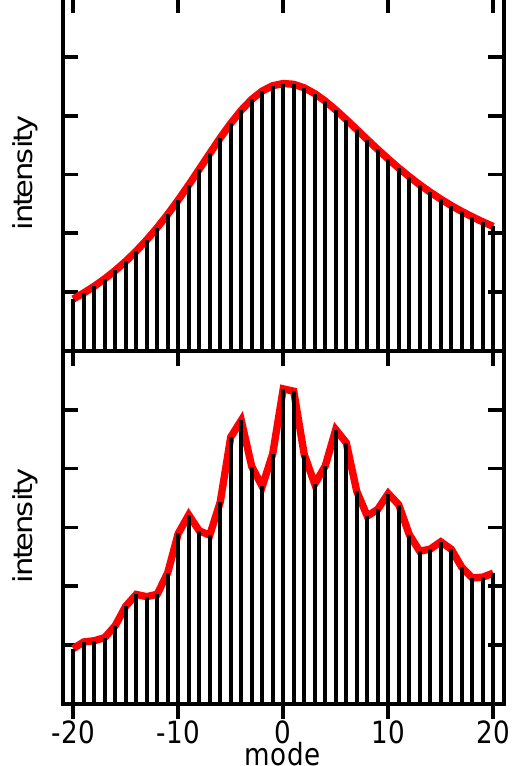
Figure 5. Simulations of the below-threshold spectral output for no short-external-cavity (SXC) in the upper panel and for operation in a SXC in the lower panel. Note the modulated spectral envelope for operation of the laser in an SXC. Above threshold, the SXC laser operated with a SMSR of − 30 dB, as shown in Figure 2 of [25]. A measured below-threshold spectral output is shown in Figures 2–4 of